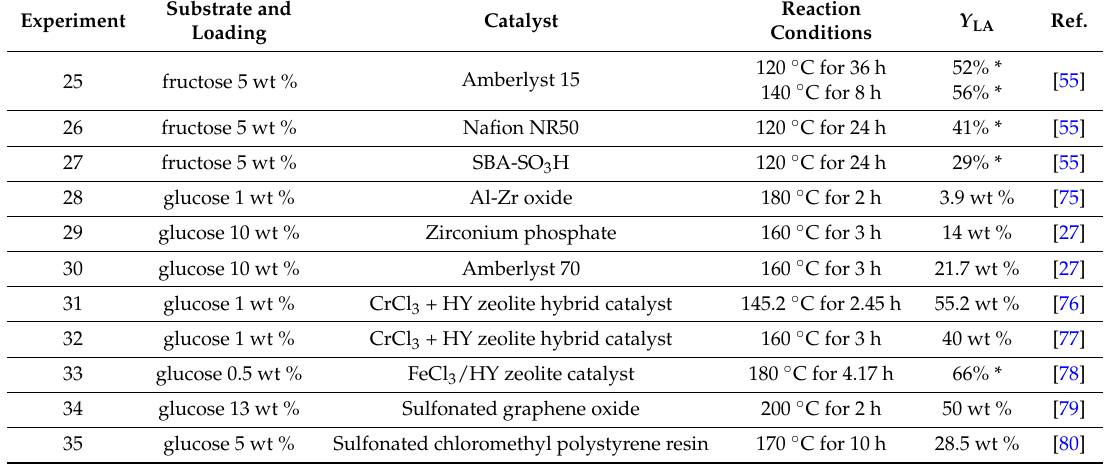
Table 3. C 6 sugars conversion in water in the presence of heterogeneous catalysts: reaction conditions.